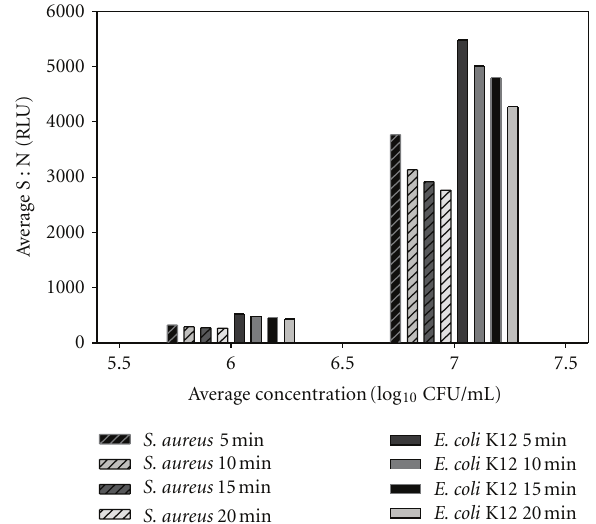
Figure 1: Standard ATP assay results for S. aureus and E. coli K12 at 10 6 and 10 7 CFU/mL. Organisms were suspended and serially diluted in Mueller Hinton II broth containing 0.1% Tween-80 and evaluated using the BacTiter-Glo basic ATP